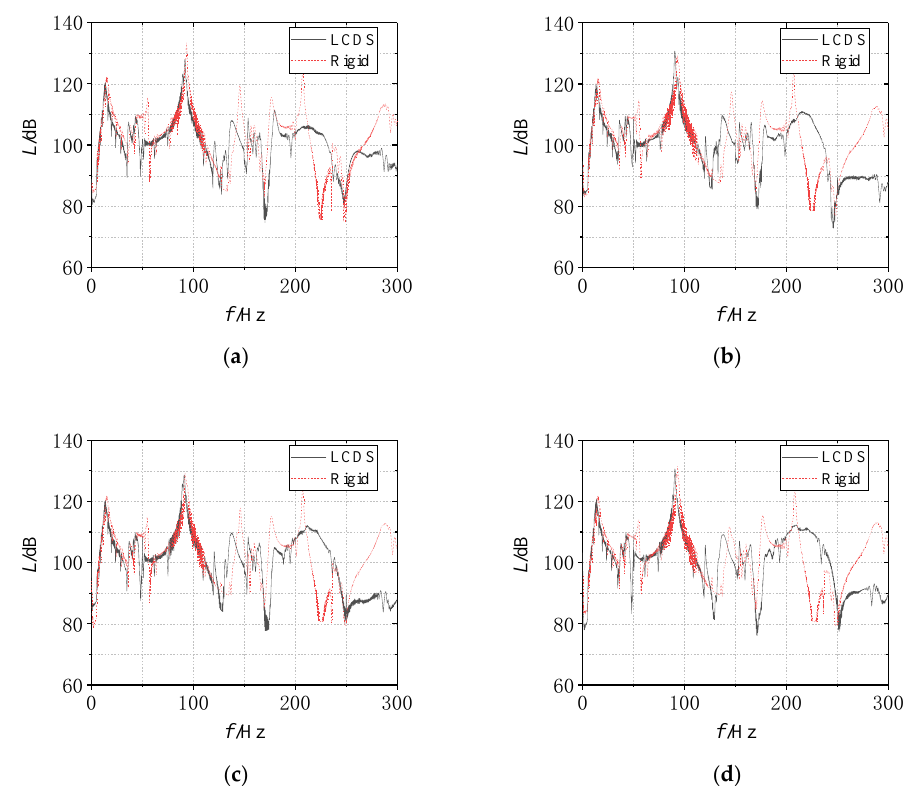
Figure 16. Vibration response curve of pipeline at different ambient temperatures: ( a ) 25 °C; ( b ) 100 °C; ( c ) 200 °C; ( d ) 300 °C.